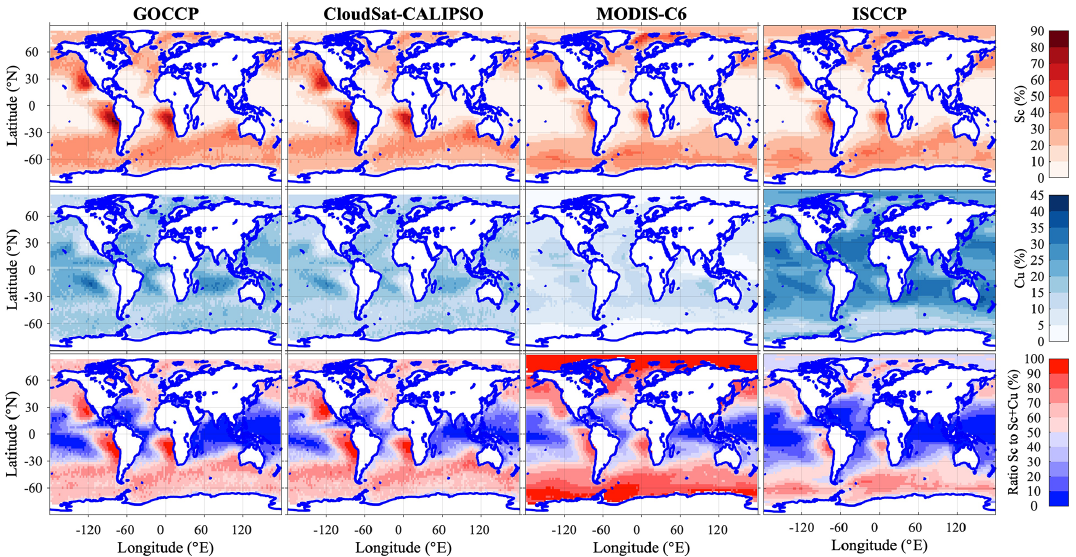
Figure 15. Similar to Fig. 13, maps ( x axis, longitude, ◦ E; y axis, latitude, ◦ N) of (top to bottom) Sc , Cu and the ratio Sc to Sc and Cu cloud fraction (%) for (left to right) GOCCP (2007–2016), RL-GeoProf (2007–2010), MODIS Terra and Aqua cloud regime (2003–2015), and ISCCP weather state